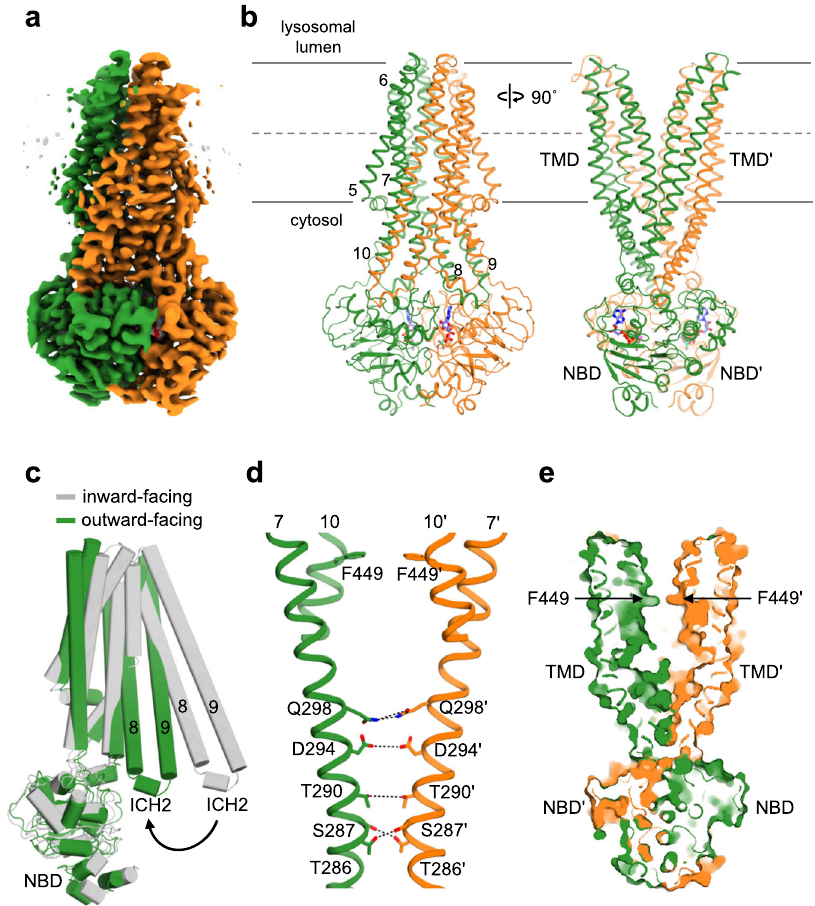
Fig. 7|Theoutward-facingconformation.a 3D reconstructionofoutward-facing Δ TMD0. b Cartoonrepresentationofoutward-facing Δ TMD0.TheboundMg 2+ and ADP·BeF 3 are represented by a sphere and a stick, respectively. c Structural com- parison of the inward-facing and outward-facing monomer. Both are from